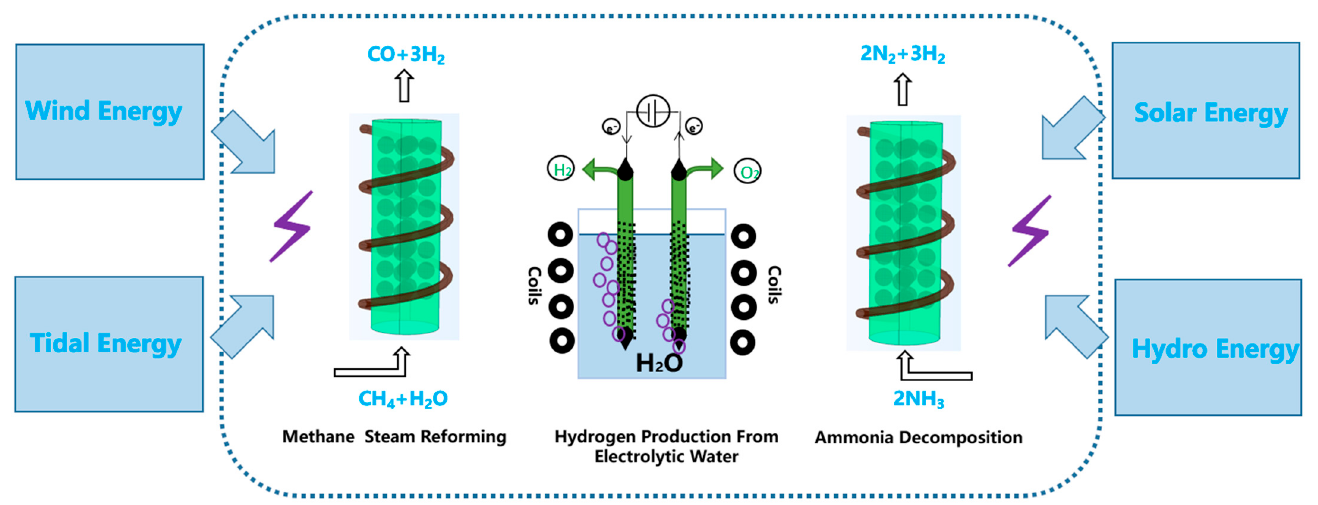
Figure 1. Renewable energy induction heating hydrogen production.